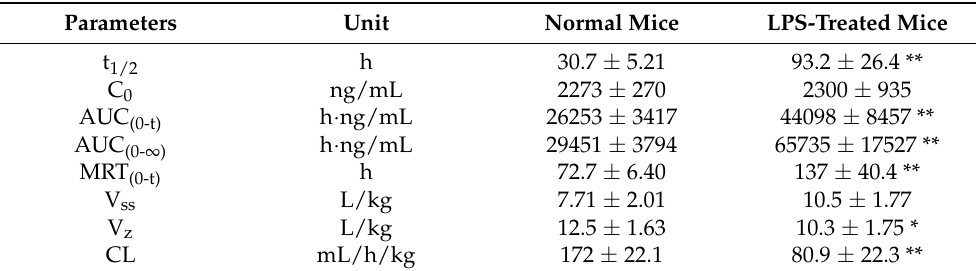
Table 1. Pharmacokinetic parameters of TET in blood after a single i.v. administration in normal and LPS-induced ALI mice ( n = 6, Mean ± SD).